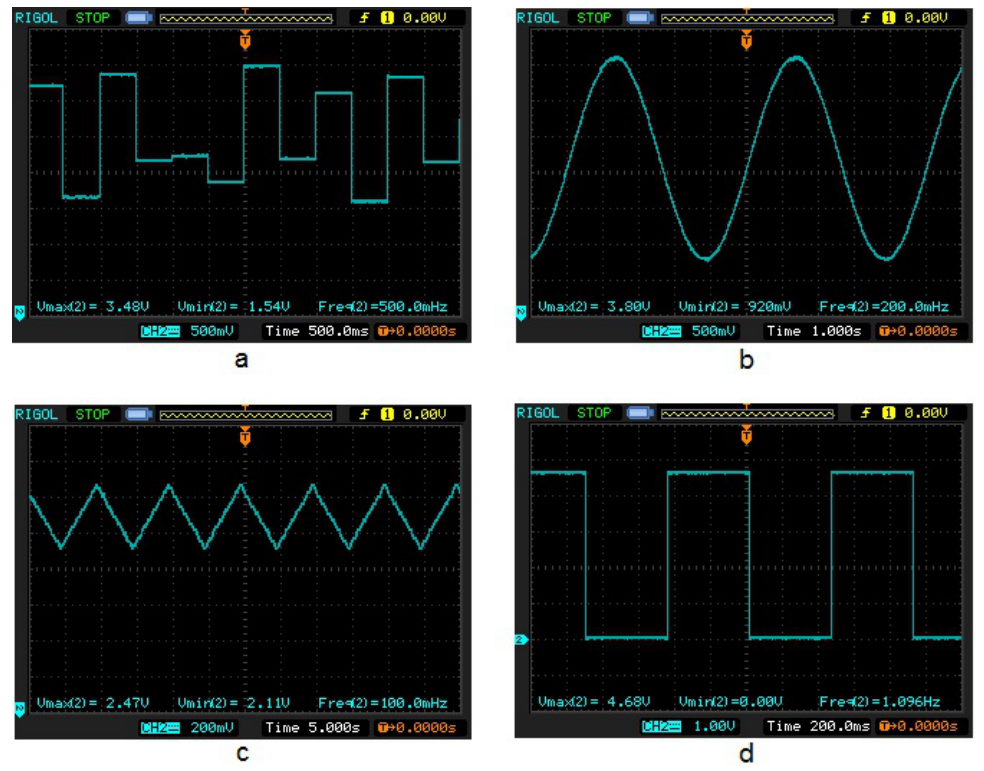
Figure 26. Generated signals viewed on a RIGOL oscilloscope. ( a ) RSAC, ( b ) SPSS, ( c ) SPCS, ( d )